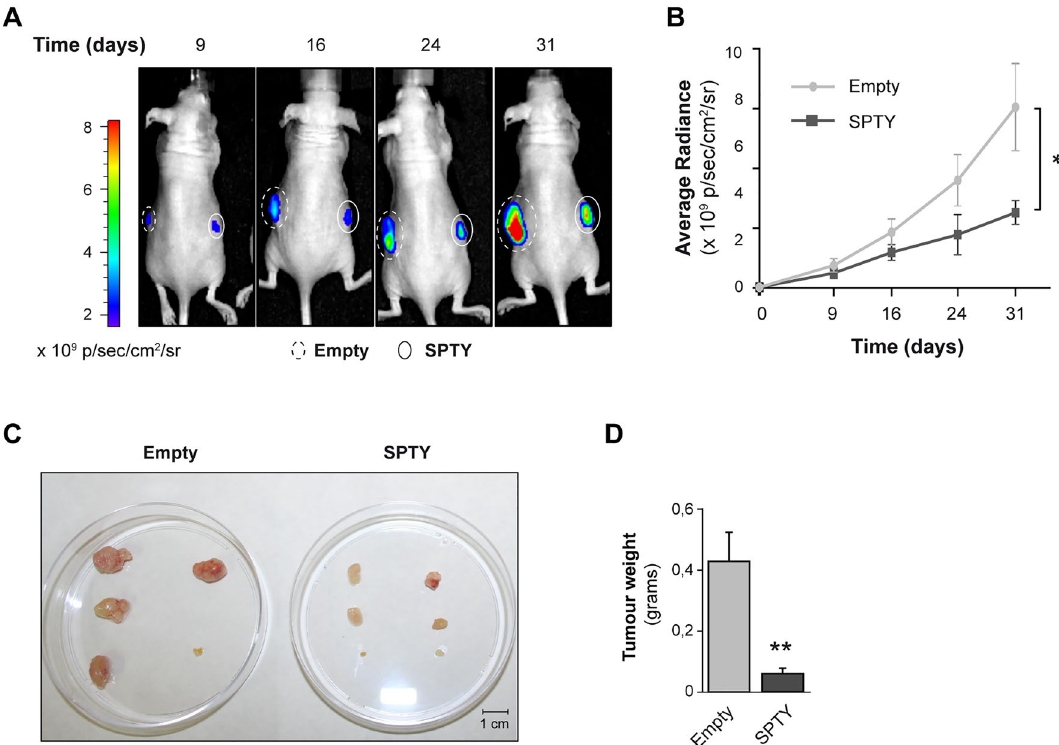
Figure 4. SPTY2D1-AS1 overexpression decreases tumor growth in vivo. Xenograft tumors were generated by subcutaneous injection with Cal62-Luc cells overexpressing SPTY2D1-AS1 (SPTY) or control (empty) vector. ( A ) Representative images of the bioluminescent signal of the generated tumors at the indicated time points. ( B ) Tumor radiance quantification at the indicated time points. ( C ) Generated tumors after excision. ( D ) Tumor weight of the generated tumors. Values represent mean ± SEM. *p < 0.05; **p <